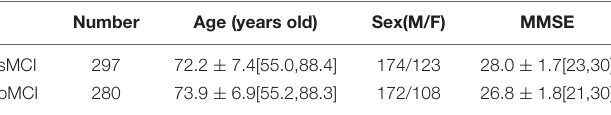
TABLE 1 | A summary of the demographic and clinical information of